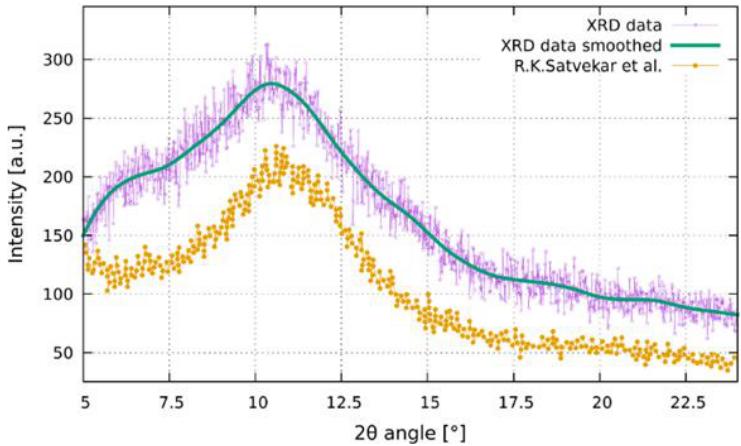
Figure 2. X-ray power diffraction pattern of silica-based xerogel [21].